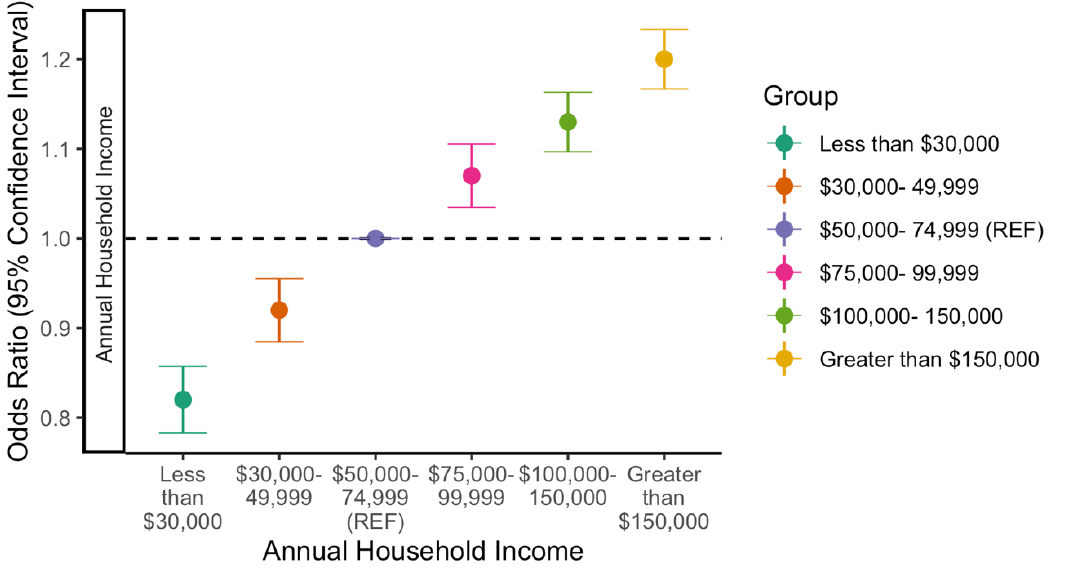
Figure 1. Likelihood to complete COVID-19 vaccination by annuals household income adjusted for age, race, health insurance, professional industry, essential worker status, and political